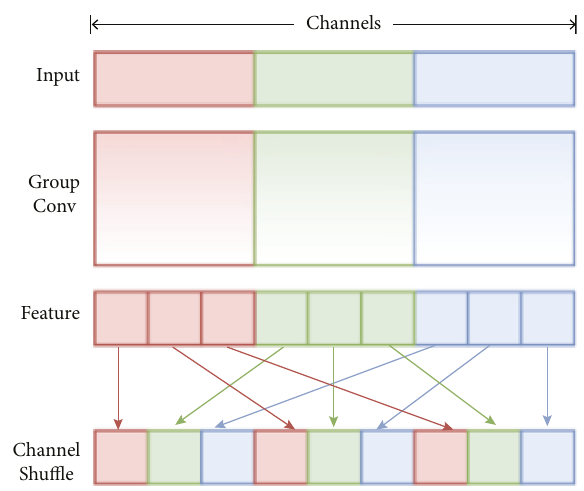
Figure 4: Channel shuffle operation of ShuffleNet (https://bit.ly/ 3NpOFFX).